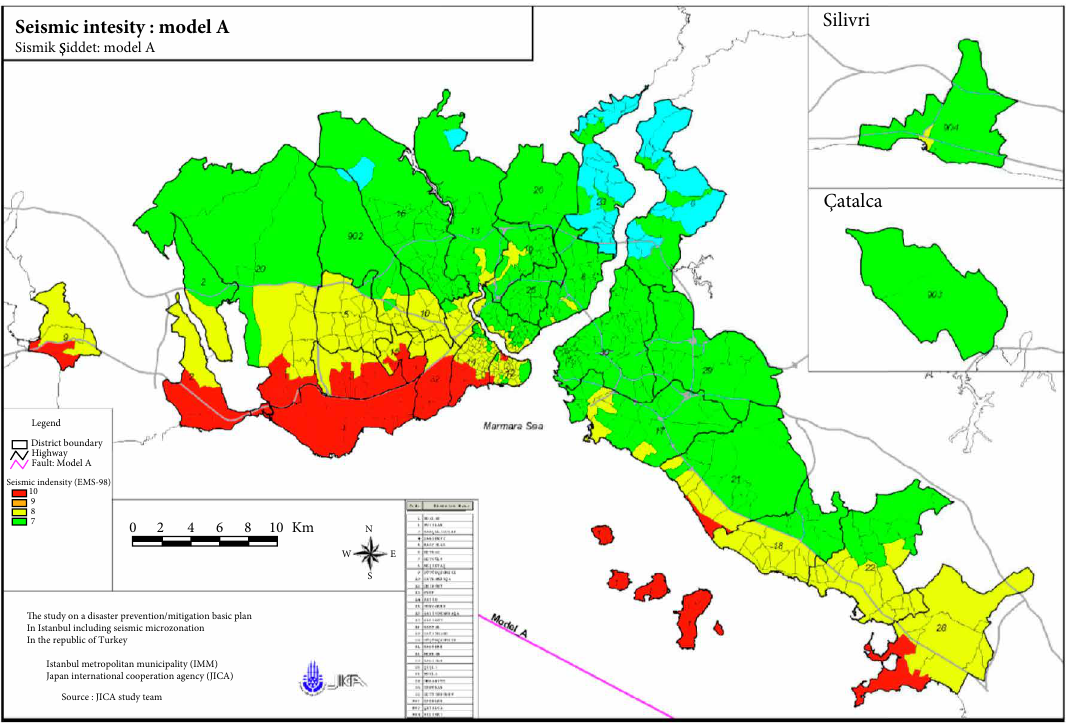
Figure 3: Seismic intensity in model A [1].